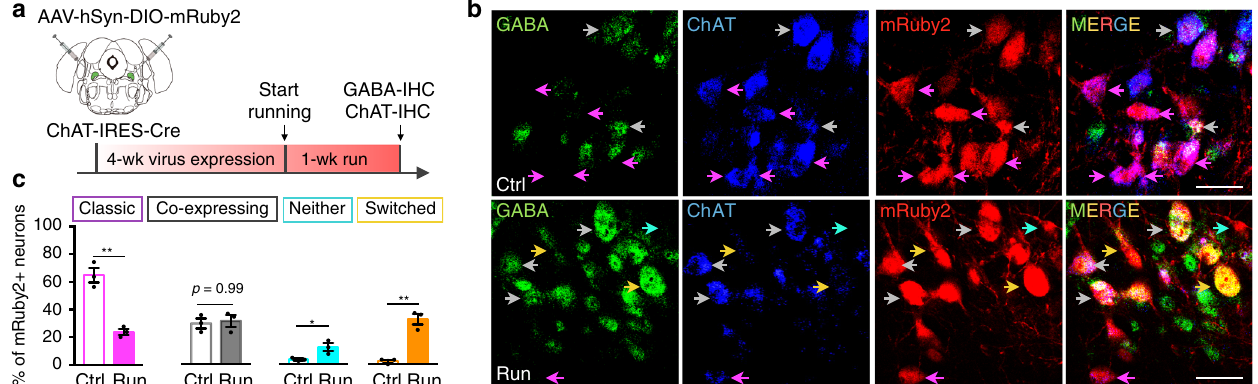
Fig. 3 A subset of cholinergic cPPN neurons lose ChAT and gain GABA. a Experimental strategy to permanently label cholinergic cPPN neurons with mRuby2 fl uorescent protein by expressing Cre-dependent AAV-DIO-mRuby2 in ChAT-Cre mice and determine whether the loss of ChAT and gain of GABA occur in mRuby2 + neurons. The coronal brain section was drawn according to the Franklin & Paxinos brain atlas 57 . b Double immunostaining of GABA and ChAT in the cPPN of a control and a 1-week runner ChAT-Cre mouse expressing AAV-DIO-mRuby2 in the cPPN. Purple arrows, mRuby2 neurons that express ChAT but not GABA (classic ChAT neurons). Gray arrows, mRuby2 neurons that express both ChAT and GABA (co-expressing neurons). Yellow arrows, mRuby2 neurons that express GABA but not ChAT (switched neurons). Cyan arrow, a mRuby2 neuron that expresses neither GABA nor ChAT. Scale bar, 50 μ m. c The percentage of each class of mRuby2 + neurons ( n = 844 for controls and 738 cells for runners). For b , c , n = 3 animals per group. Statistical signi fi cance * p < 0.05, ** p < 0.01 was assessed by Mann – Whitney U test. Data shown are mean ±